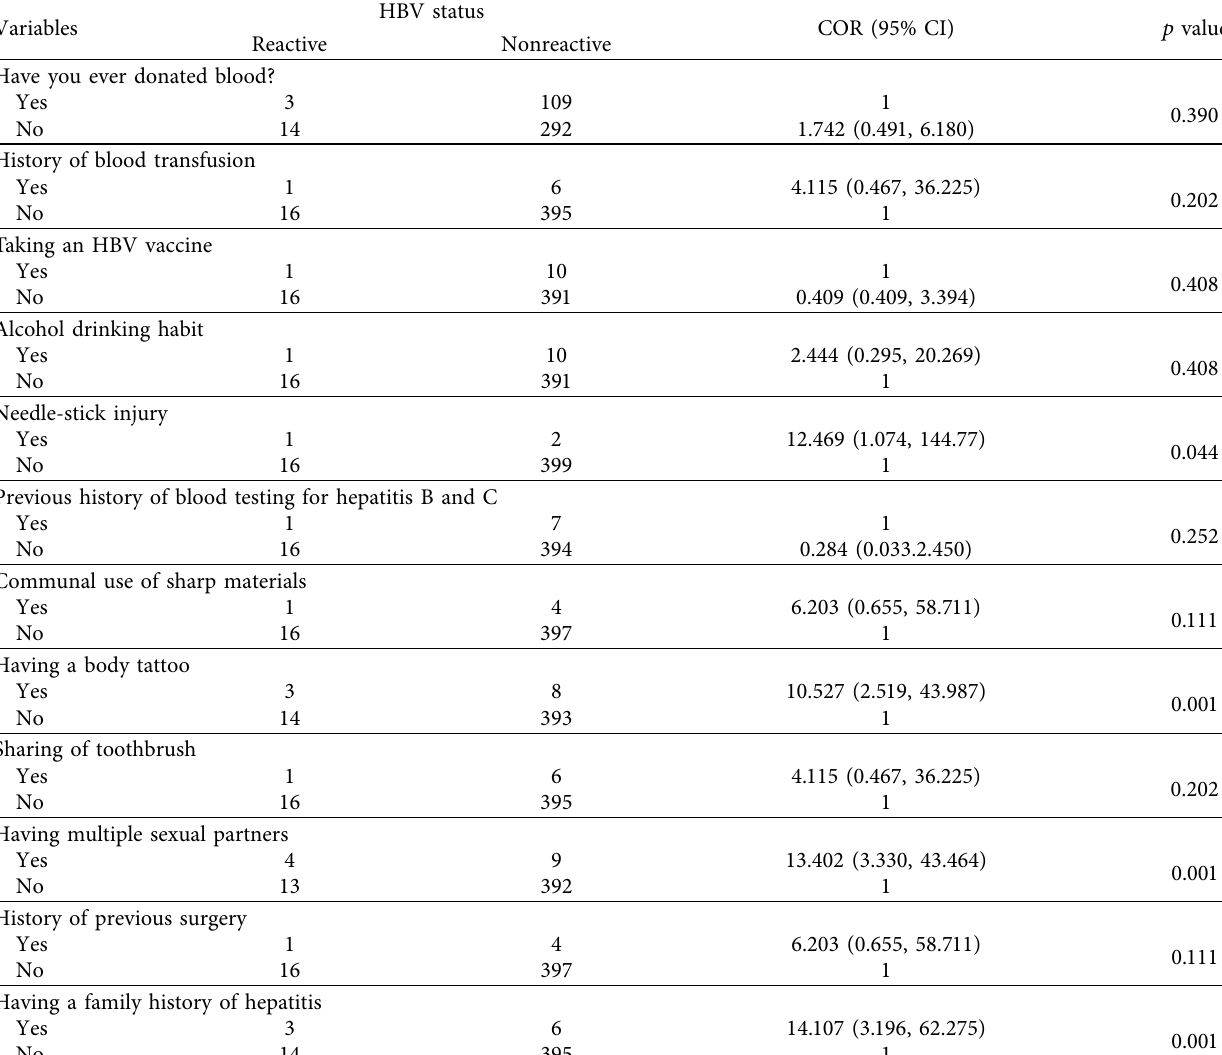
Table 5: Bivariate analysis of clinical factors with HBV among blood donors at Bahir Dar Blood Bank centre, Northwest Ethiopia, 2020 ( n � 418).